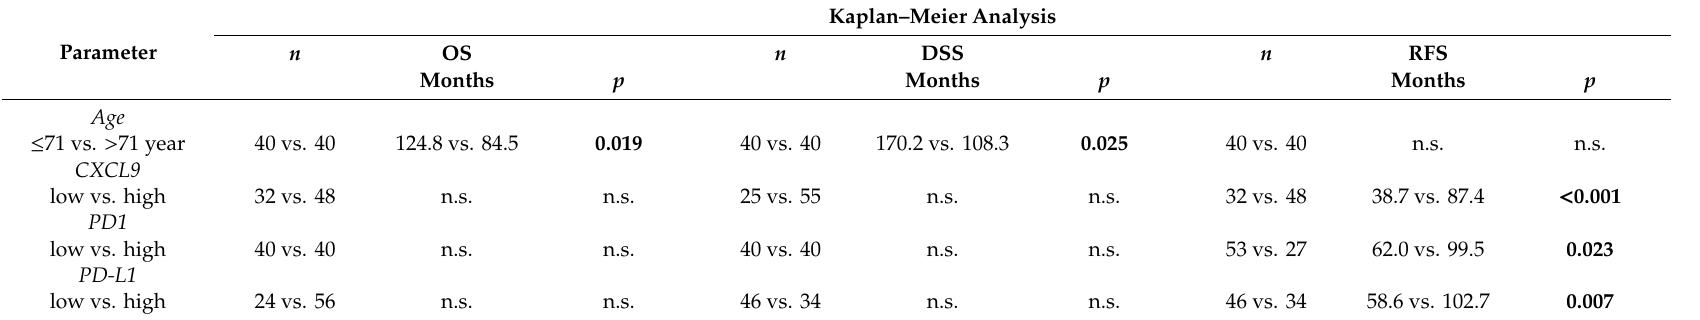
Table 2. Kaplan–Meier analysis of the association of age, CXCL9 , PD1 and PD-L1 mRNA with prognosis.